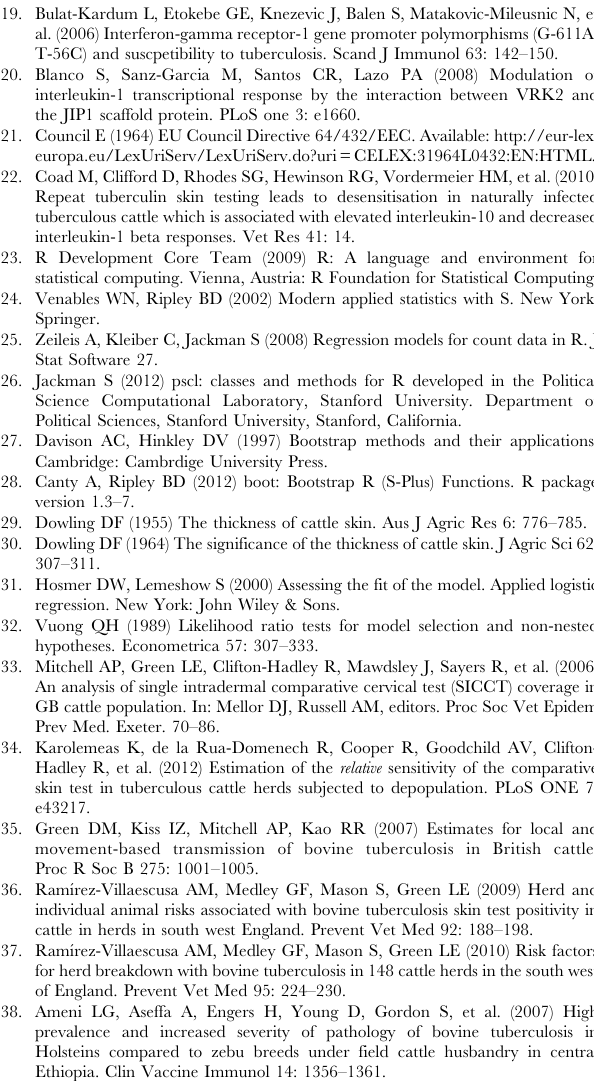
Table S4 Data set used for fitting models. Columns are: # =sample number; Age= age at slaughter in days; Breed, given as the breed code, see Table 1; a1, a2, b1 and b2 are the four swelling size measurements given as first (1) and second (2) for the avian (a) and bovine (b) injection sites; da and db are the swelling size differences, given as the second minus the first swelling size measurements at the avian (da) and bovine (db) injection sites; status =R for reactor and NR for non-reactor; p22= genotype at microsatellite INRA111 with TRUE= ‘22’ and FALSE = not